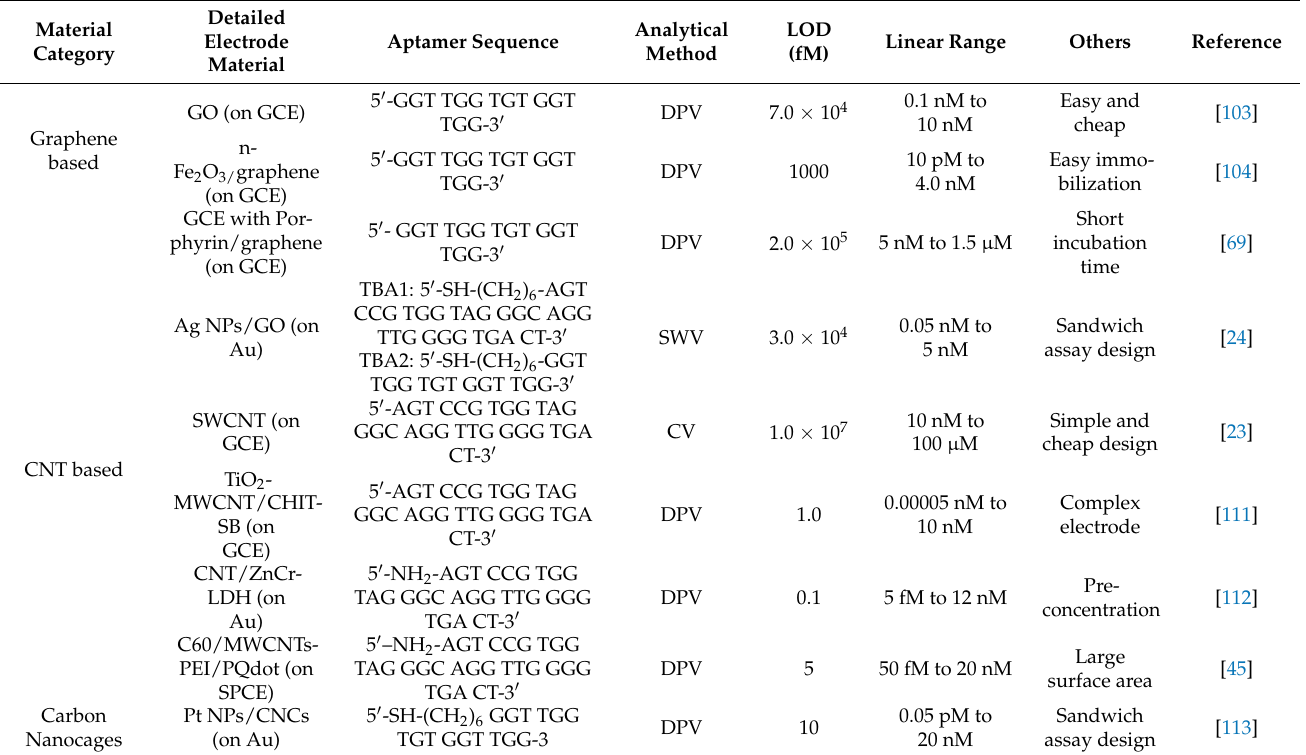
Table 3. Summary and comparison of carbon nanomaterial-based